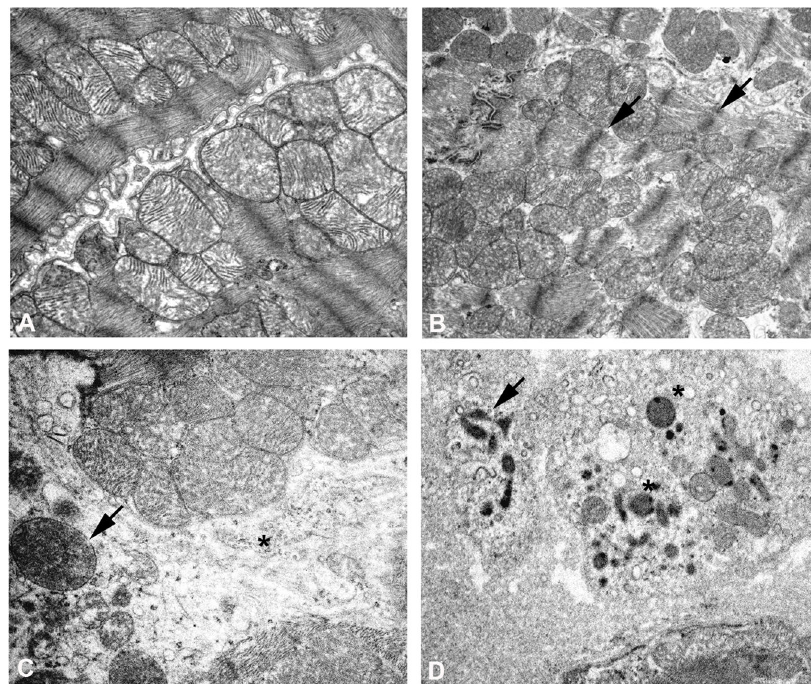
Figure 3. Ultrastructural analysis of WT and NTT-MMP-2 transgenic hearts at six months of age. Transmission electron microscopy of left ventricular free walls from WT (panel A) and NTT-MMP-2 transgenic hearts at 6 months of age (panels B-D). As compared to the WT controls, there is a clear loss of sarcomeric organization and Z-band registration in the NTT-MMP-2 transgenic cardiomyocytes. The mitochondria are heterogeneous in size and frequently swollen (panel C), with areas of organelle dropout (*). Further, there is ultrastructural evidence for autophagy (panel D), with abundant lysosomes (*) and autophagosomes (arrow).